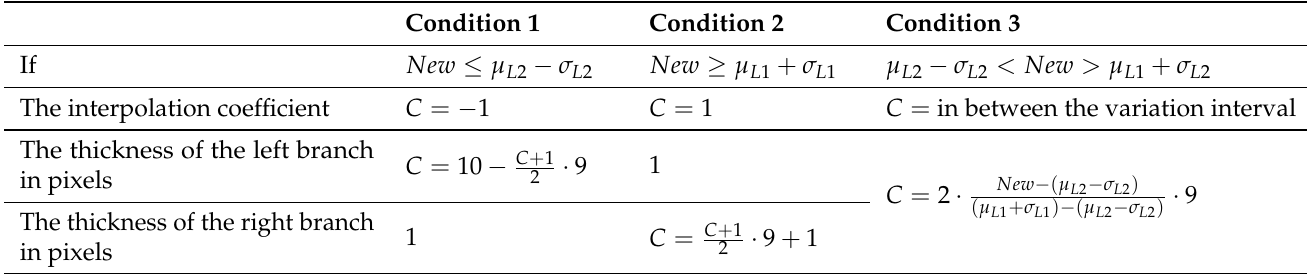
Table 5. Formalization of the three conditions for the slope coefficient of the new candidate entering into the system